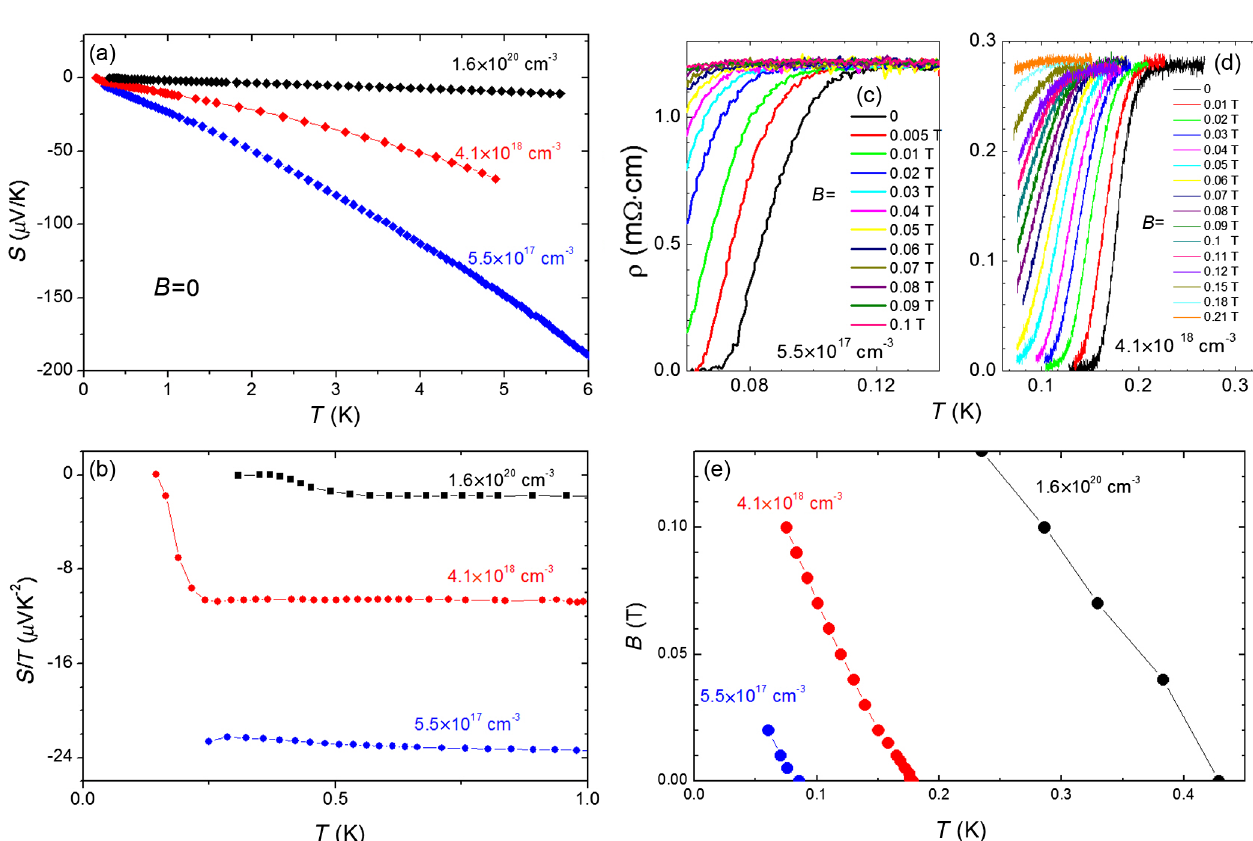
FIG. 5. (a) The temperature dependence of the zero-field Seebeck coefficient for three different carrier concentrations. (b) The temperature dependence of S=T . As is seen in the figure, the diffusive component of thermopower becomes larger with underdoping, which is indicative of a decrease in the Fermi energy. (c),(d) Superconducting resistive transition for two different carrier concentrations in the presence of a magnetic field. (e) Temperature dependence of the upper critical field near T c (defined as the temperature at which resistivity drops by half) for three carrier